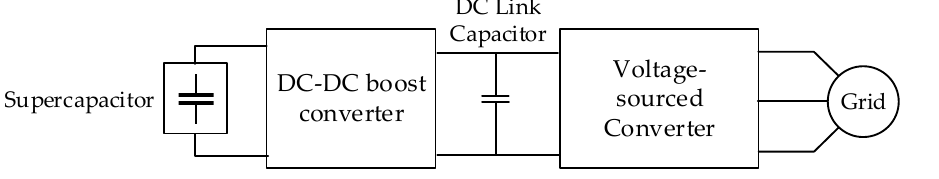
Figure 2. Supercapacitor energy storage unit.